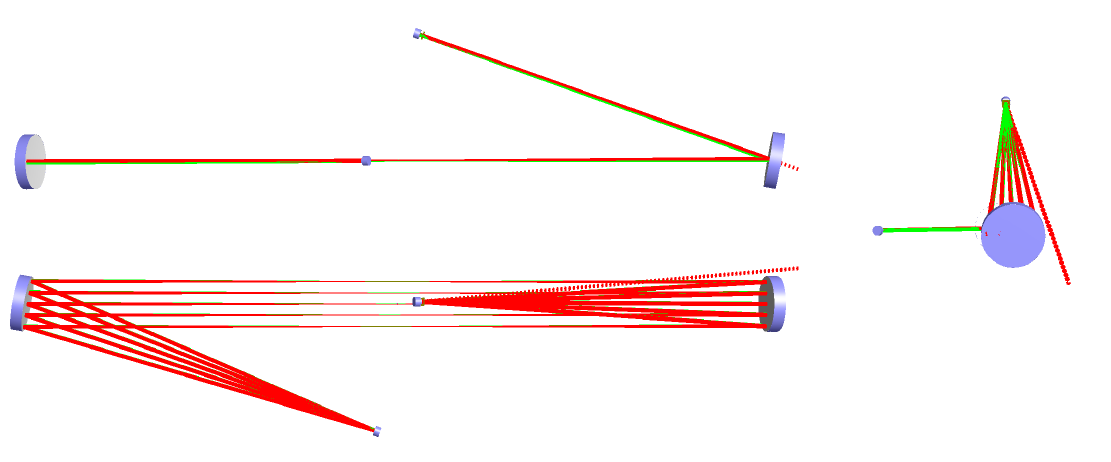
Figure 10. Different views of a compensated Type I system with five round-trips and θ = 10 ◦